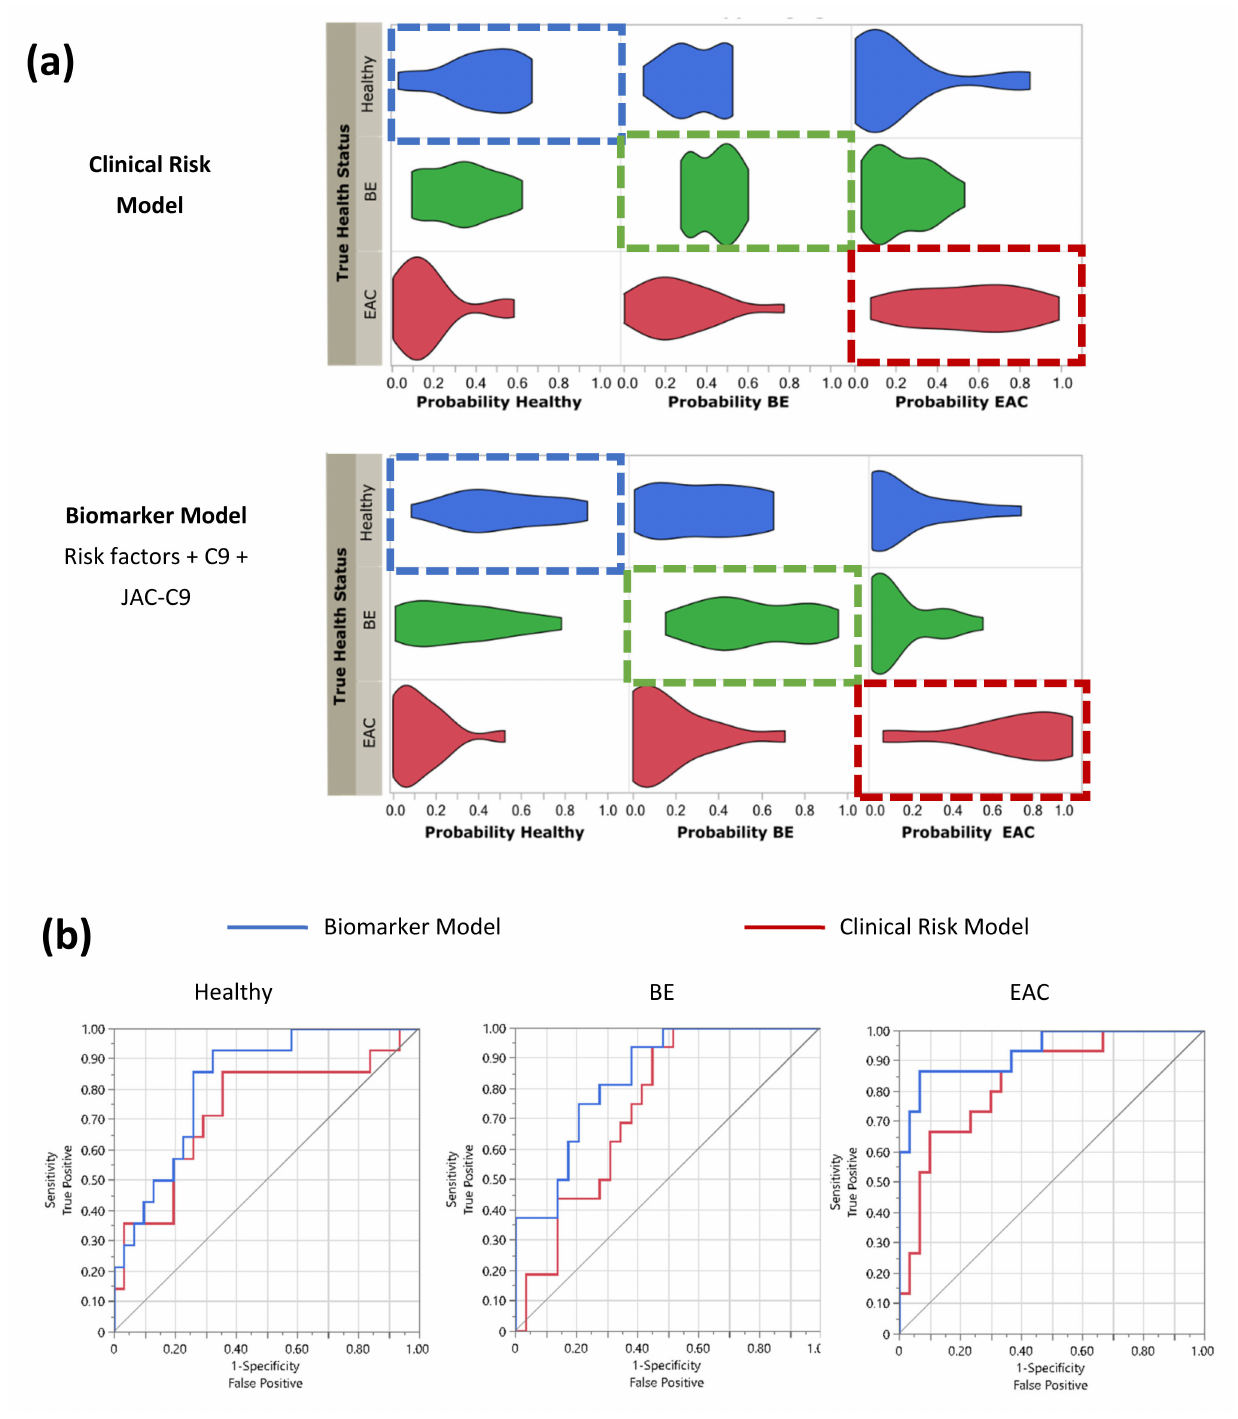
Figure 5. Serum biomarkers improve patient stratification in the study cohort. Logistic regression modelling was conducted on the cohort ( n = 46) for classification as Healthy, BE or EAC, using patient risk factors of BMI, age and heartburn/reflux history alone (Clinical Risk Model), or risk factors plus serum biomarkers C9 and JAC-C9 (Biomarker Model). ( a ) Probability of health status was plotted as a violin plot against true classification. Boxes indicate the true health status, shift to the right indicates improved classification. ( b ) Receiver operating curve (ROC) for correctly predicting health status for Clinical Risk Model (red) vs. Biomarker Model (blue). See Table 2 for